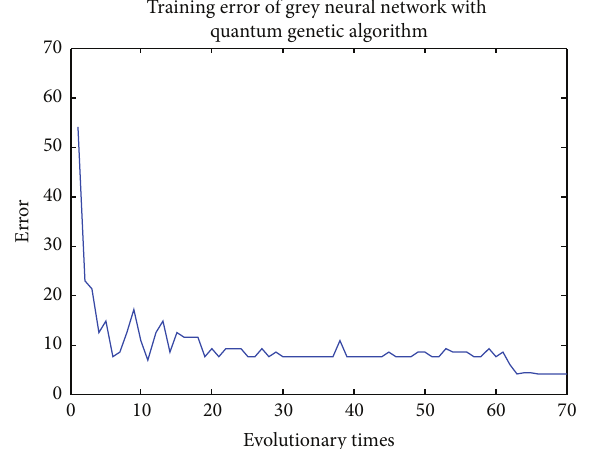
Figure 10: The change in the training error of the gray neural network with quantum genetic algorithm.